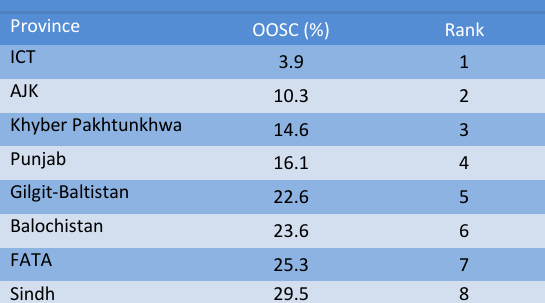
Table 2: Out-of-School Children in Provinces (%)